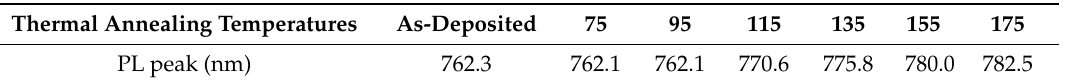
Table 1. Peak positions in PL spectra of (FAPbI 3 ) 1 − x (MAPbBr 3 ) x deposited on glass substrates and annealed various temperatures.